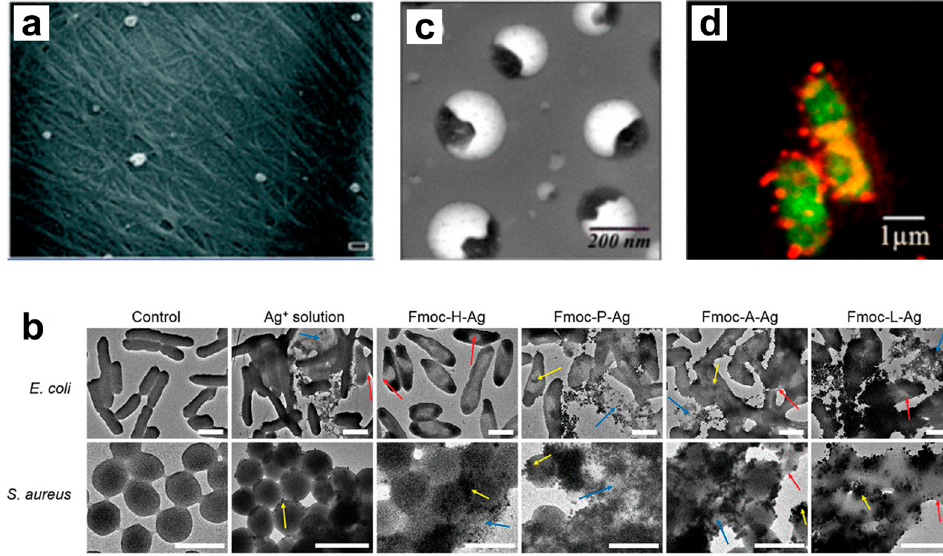
Figure 11. ( a ) SEM images of silver nanoparticles entangled within a napthelene-functionalized tripeptide hydrogel network. Adapted from [163] with permission from The Royal Society of Chemistry. ( b ) Demonstration of membrane fusion (red arrows), clumping (yellow), and disintegration (blue) of various peptide-silver nanoparticle complexes. Image adapted from [164] under the Creative Commons Attribution 4.0 International License http: // creativecommons.org / licenses / by / 4.0 / . ( c ) High-resolution TEM images of zinc-coordinated poly peptide nanogels (PNGs). ( d ) Confocal microscopy of PNG (red)-treated E. coli cells (green). Adapted with permission from [165]. Copyright 2019 American Chemical Society.